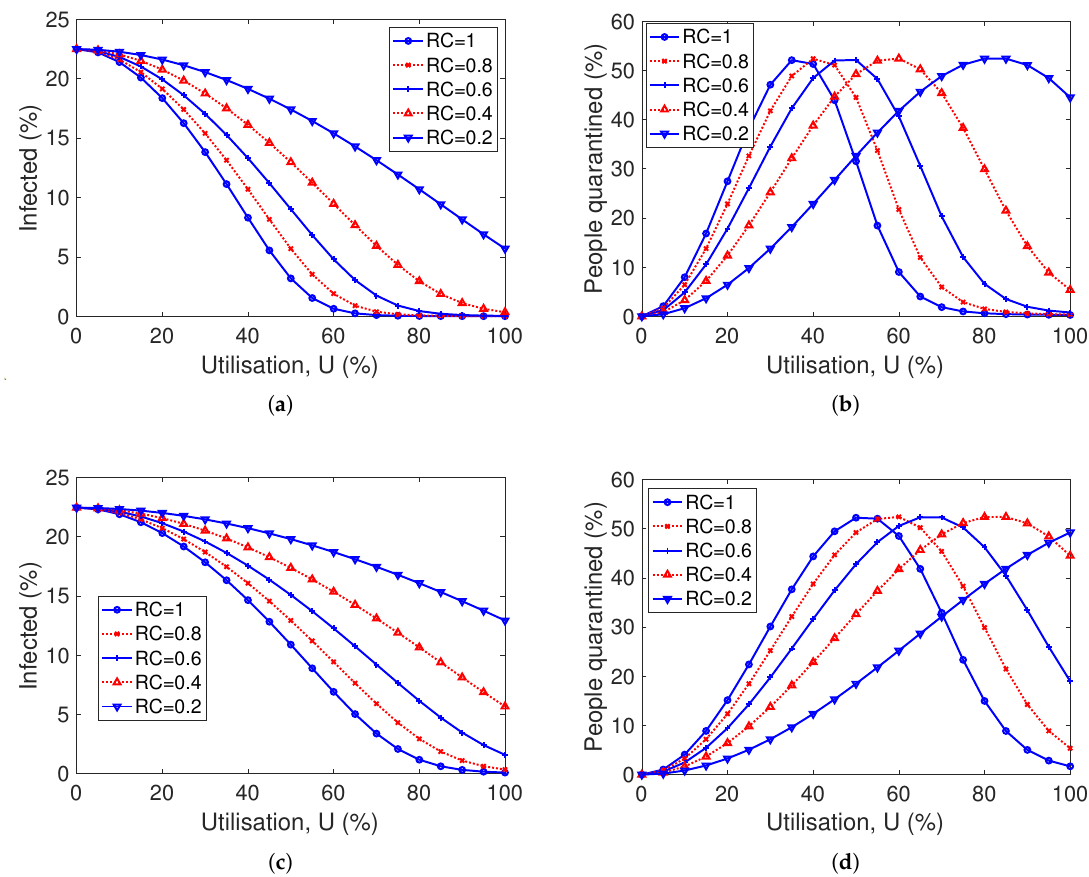
Figure 6. Efficiency of the contact tracing application considering the tracing time (all plots are for R 0 = 2): ( a , b ) percentage of population infected and quarantined when tracing time is 2 days ( TT = 2); ( c , d ) percentage of population infected and quarantined considering when tracing time is 4 days ( TT =